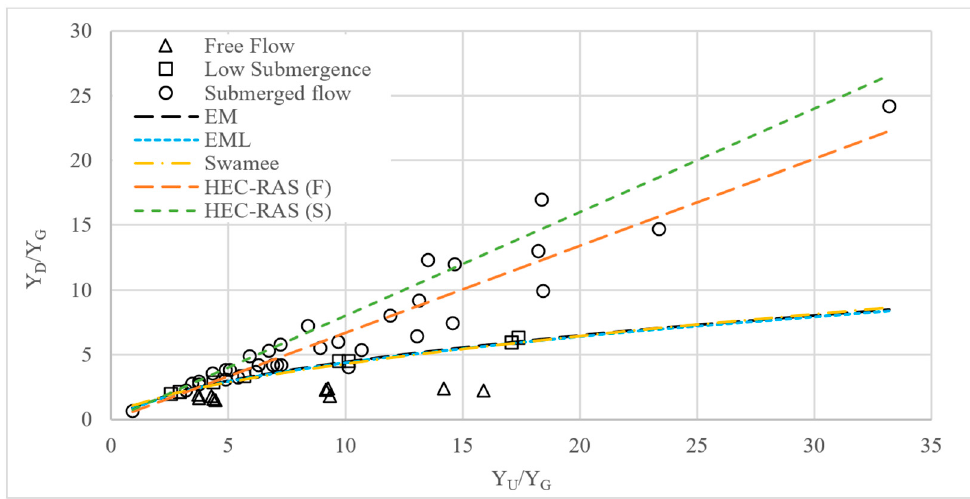
Figure 5. Lab experiment results (markers) categorized by observed flow regime, compared with predicted flow regimes by each model (lines).